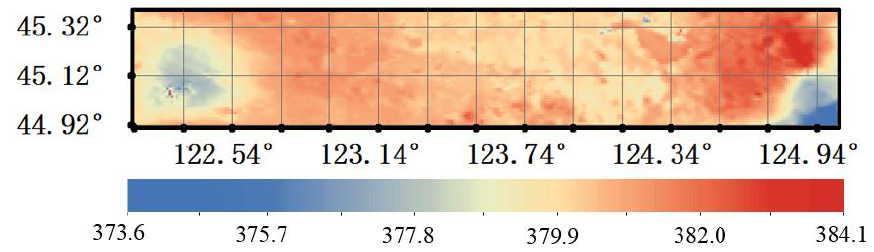
Figure 8. Approximate XCO 2 surface in the flight test area.